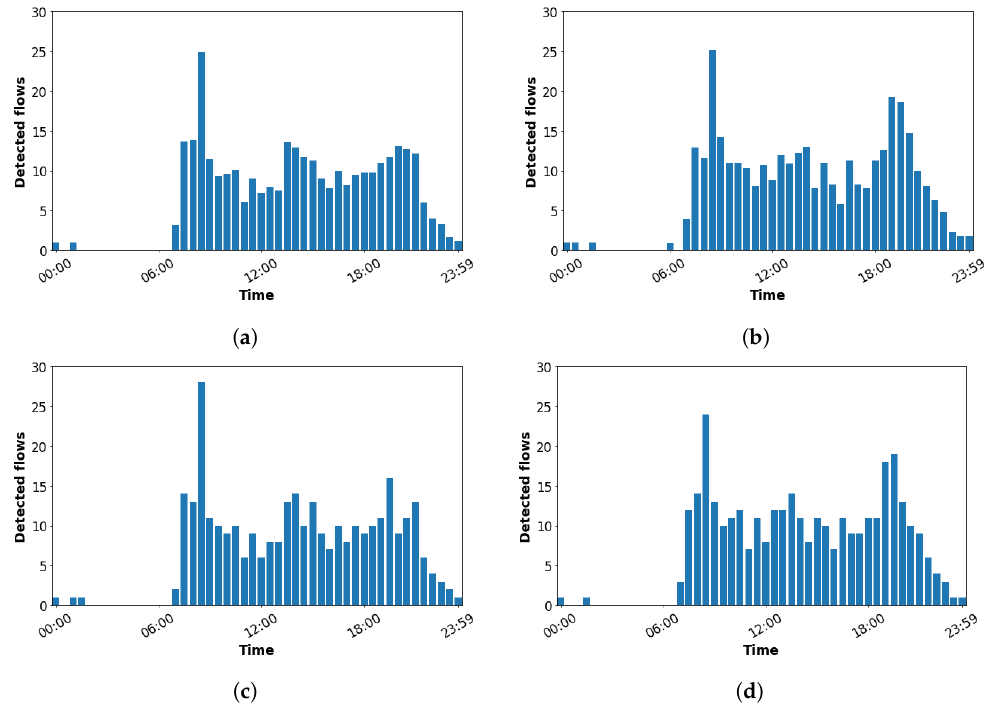
Figure 7. Mean number of detected flows over the day during working days. ( a ) Flow A: from Sensor 2 to Sensor 3; ( b ) Flow B: from Sensor 3 to Sensor 2; ( c ) Flow C: from Sensor 3 to Sensor 4; ( d ) Flow D: from Sensor 4 to Sensor